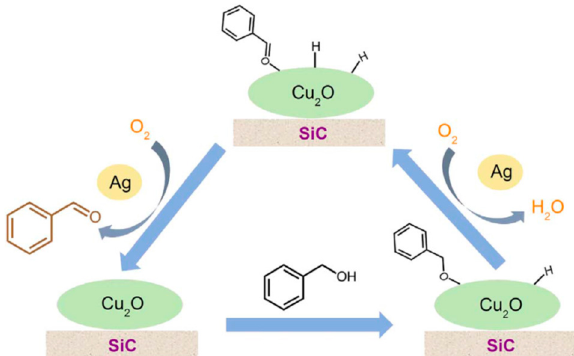
Figure 7. The catalytic mechanism of pre-activated Ag 2.5 Cu 5 /SiC for the gas-phase selective oxidation of benzyl alcohol. Reprinted with permission from reference [74]. Copyright 2017 Elsevier.